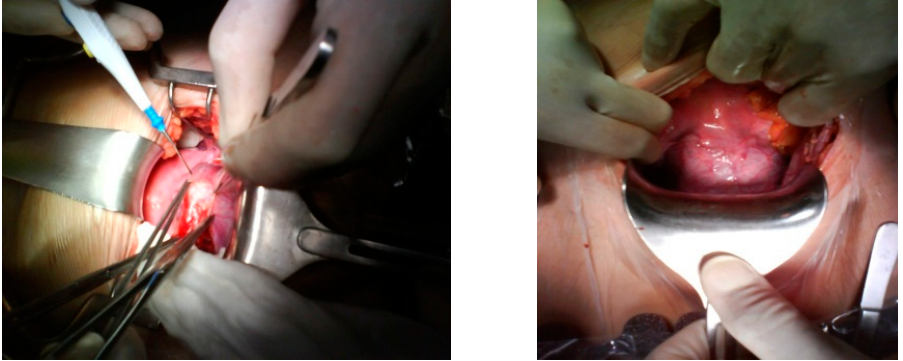
Figure 6. Gestational sac visible through myometrial anterior aspect.